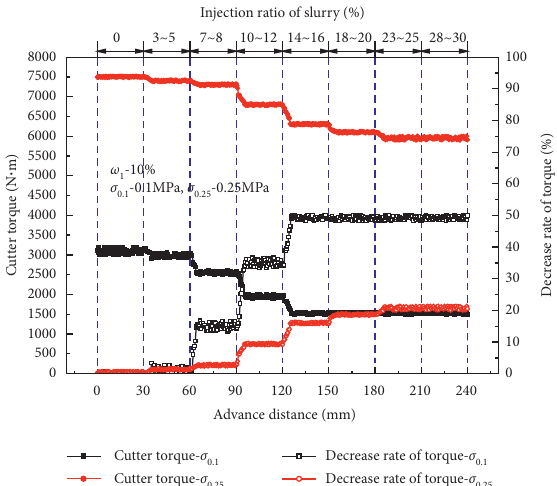
Figure 26: Effect of slurry conditioning and soil pressure on cutter torque at water content 10%.